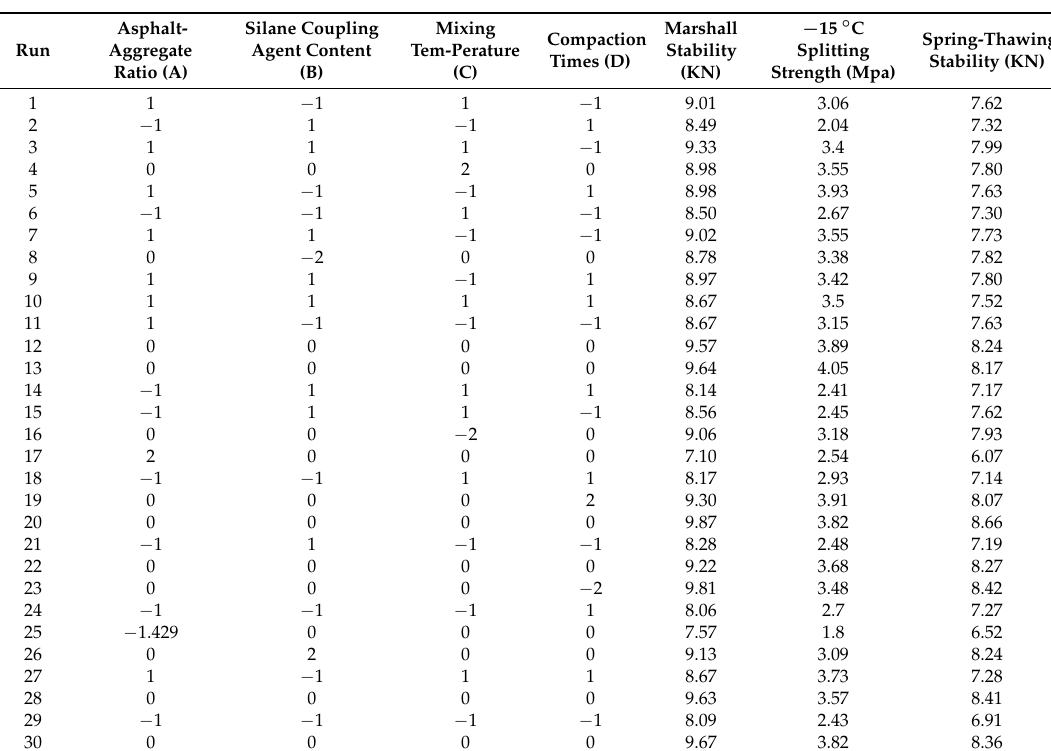
Table 5. Central composite design.